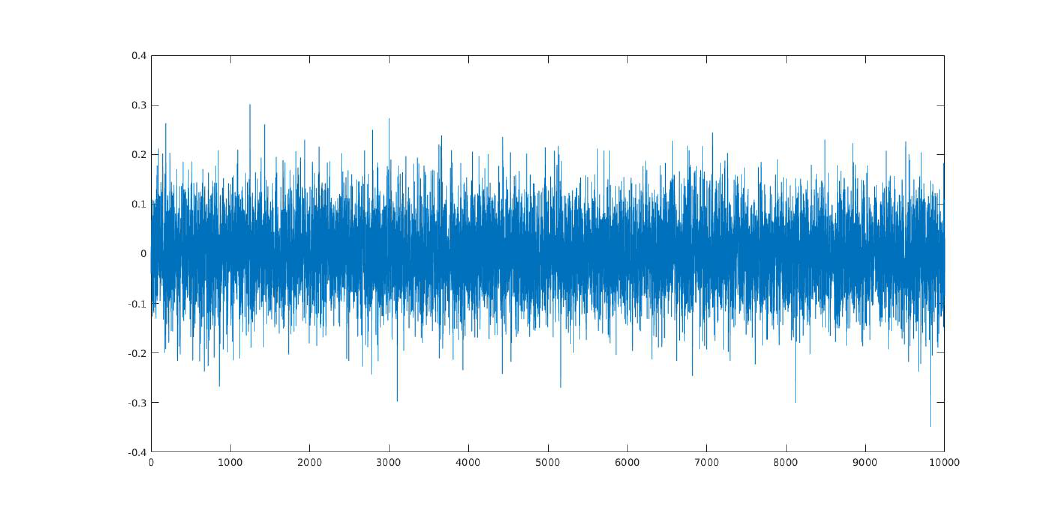
Figure 4.2: TVLA of Composite-TI circuit for CA-Based S-Box representing class (1 , 3 , 1) collected 1 000 000 power trace samples from the target FPGA device, and performed a fixed-versus-random statistical test vector leakage assessment (TVLA) test on these collected traces. The fixed class for the test was chosen as the all-zero input in all our evaluations. Figure 4.2 demonstrates the result of the TVLA analysis on the power traces. The outcome of the statistical test consists of values in the range ( − 0 . 4 , 0 . 3), which is well within the permissible range of ( − 4 . 5 . 4 . 5)